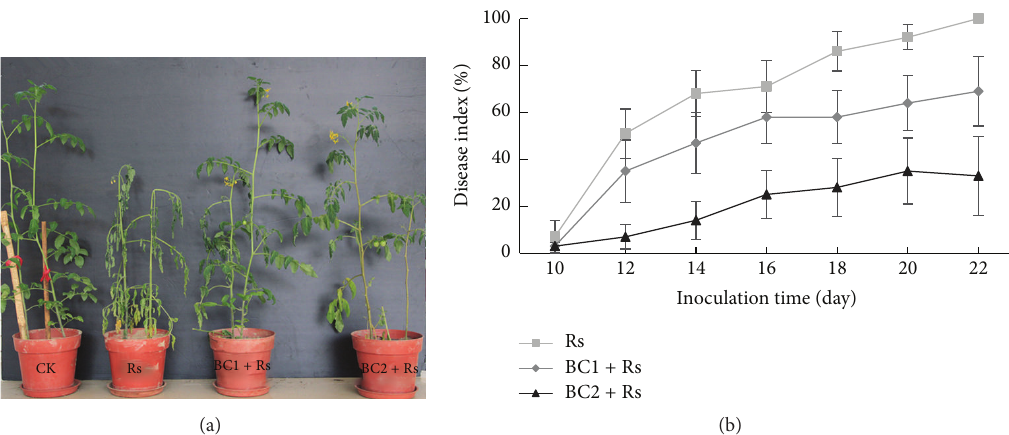
Figure 2: Suppressive effects of biochar amendment on R. solanacearum of tomato plant (a) and effects of biochar amendment and R. solanacearum inoculation on the disease index (%) of bacterial wilt in tomato plants (b). CK, no biochar and no R. solanacearum inoculation; Rs, R. solanacearum inoculation; BC1 + Rs, peanut biochar amendment and R. solanacearum inoculation; BC2 + Rs, wheat biochar (BC2) amendment and R. solanacearum